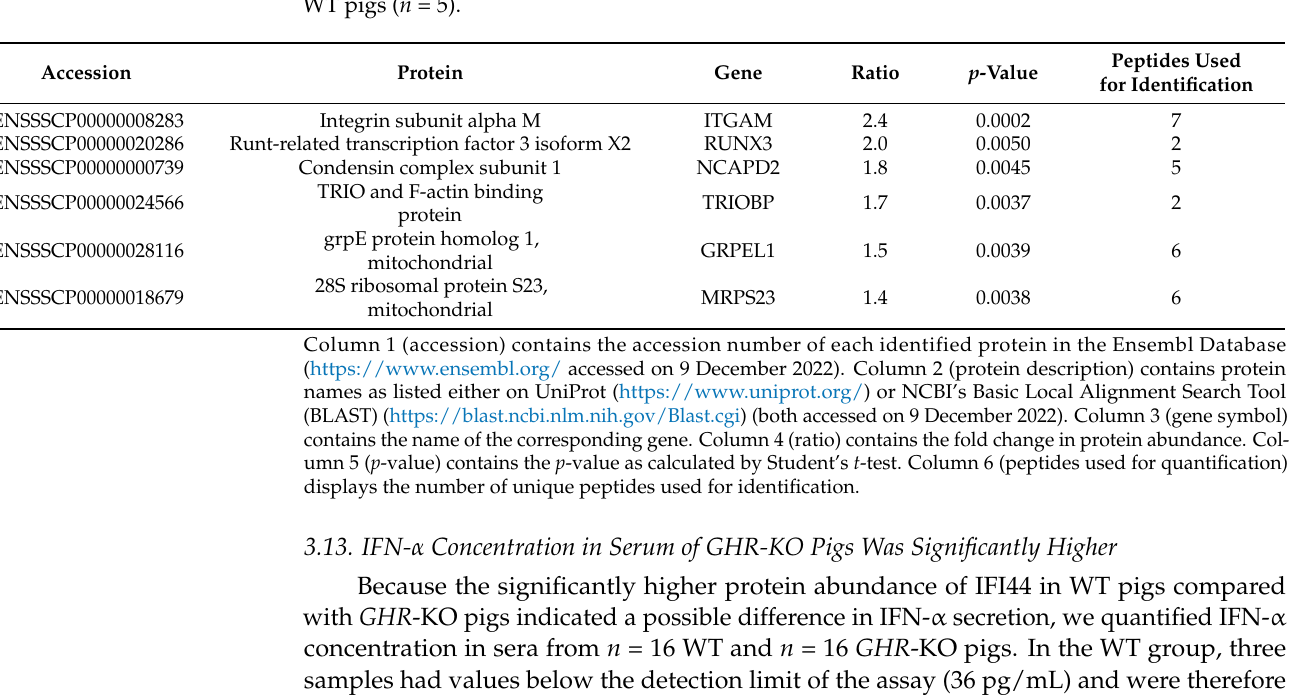
Table 6. Proteins from mass spectrometry dataset. Significantly ( p ≤ 0.01), differentially abundant proteins quantified with more than 2 peptides in CD4 − PBMCs of GHR -KO pigs ( n = 4) compared to WT pigs ( n =